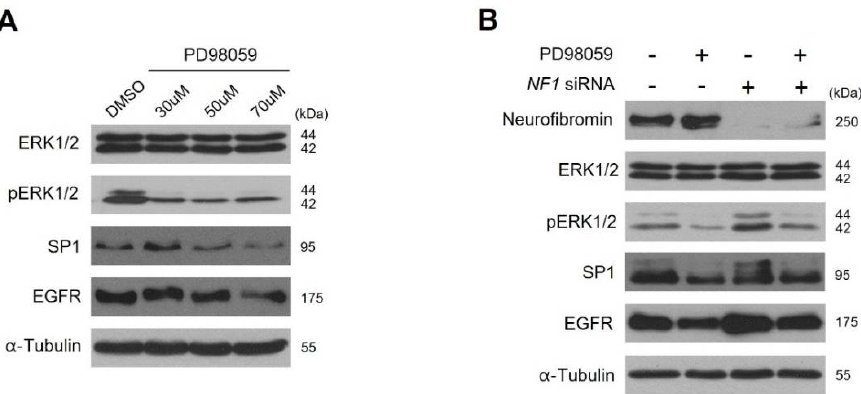
Figure 5. Correlation between ERK1/2 phosphorylation and SP1 and EGFR expression levels. ( A ) Human Schwan cells (HSCs) were exposed to the indicated concentrations of MAPK inhibitors PD98059 for 1 day in normal cell culture medium and protein extracts were determined by western blotting using the indicated antibodies. ( B ) HSCs were treated with NF1 siRNA or control siRNA for 48 h followed by an additional 24 h of treatment with 70 μM PD98059. The minus (−) for PD98059 indicates DMSO treatment, and the minus (−) for NF1 siRNA indicates control siRNA treatment. After 3 days of treatment, the levels of total α-tubulin, neurofibromin, SP1, EGFR, ERK1/2 and pERK1/2 were measured by Western blot.